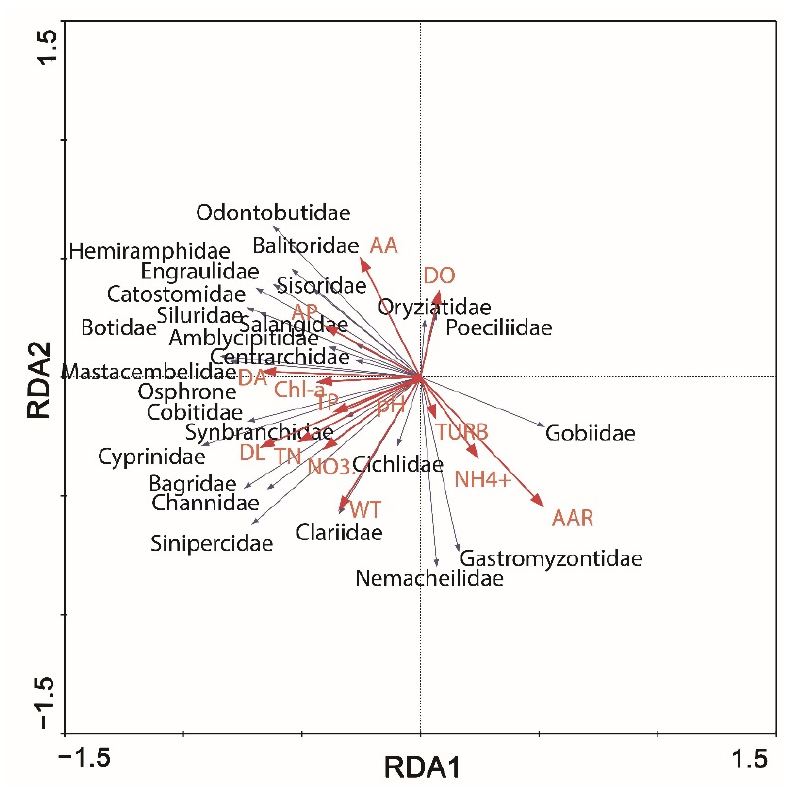
Figure 6. Ordination biplot of composition of fish species and geographical and environmental variables based on redundancy analysis in the Gan River Basin (rivers not shown). Variables include DL, drainage length (km); DA, drainage area (km 2 ); AA, average altitude (m); AP, average precipitation (mm); AAT, average air temperature ( ◦ C); DO, dissolved oxygen (mg/L); pH, hydrogenions; TURB, turbidity (NTU); WT, water temperature ( ◦ C); Chl-a, chlorophyll-a (mg/L); TN, Total nitrogen (mg/L); TP, total phosphorus (mg/L); NH 4+ , ammonium nitrogen (mg/L); and NO 3 − , nitrate nitrogen (mg/L). Table 2. Effects of geographical and environmental factors on α and β diversity of total and native fish species in the Gan River Basin based on Mantel tests in the current period. Variables include DL, drainage length (km); DA, drainage area (km 2 ); AA, average altitude (m); AP, average precipitation (mm); AAT, average air temperature ( ◦ C); DO, dissolved oxygen (mg/L); pH, hydrogenions; TURB, turbidity (NTU); WT, water temperature ( ◦ C); Chl-a, chlorophyll-a (mg/L); TN, Total nitrogen (mg/L); TP, total phosphorus (mg/L); NH 4+ , ammonium nitrogen (mg/L); and NO 3 − , nitrate nitrogen (mg/L). Significant results are in bold (* p < 0.05; ** p <